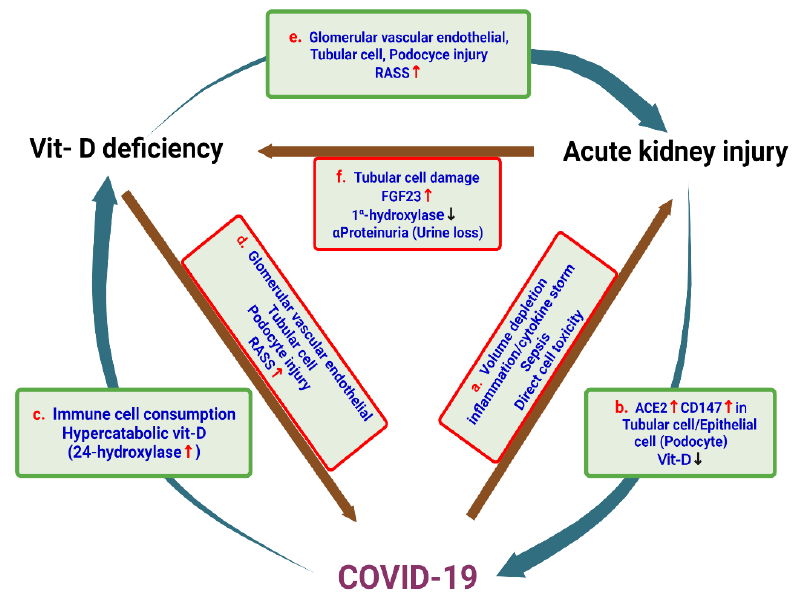
Figure 4. The relationships among COVID-19, AKI, and vitamin D deficiency. ( a ) COVID-19 can cause acute damage to the renal parenchyma directly by the virus or indirectly by factors such as body fluid deficiency and inflammation. ( b ) The kidneys in AKI are also more susceptible to SARS-CoV-2 infection because they have more virus entry receptors such as ACE2 and CD147. AKI can also cause vitamin D deficiency and increase the risk of COVID-19. ( c ) COVID-19 can elicit the immune cell response caused by the virus, resulting in the consumption of vitamin D; it also accelerates the metabolism of vitamin D, which leads to the decline in vitamin D in the body. ( d ) The lack of vitamin D activates the RAAS system inside the kidney and the whole body. At the same time, the lack of vitamin D can also easily cause damage to glomerular capillary endothelial cells, podocytes, and renal tubular epithelial cells, which will increase the chance of contracting COVID-19. ( e ) Vitamin D deficiency will activate the RAAS system and easily damage glomerular endothelial cells, podocytes, and renal tubular epithelial cells, thus increasing the incidence of AKI. ( f ) AKI will cause damage to the renal tubules and increase FGF23 levels, which will lead to a decrease in the concentration of enzymes that make vitamin D. Moreover, proteinuria in AKI will also increase urinary loss of vitamin D.